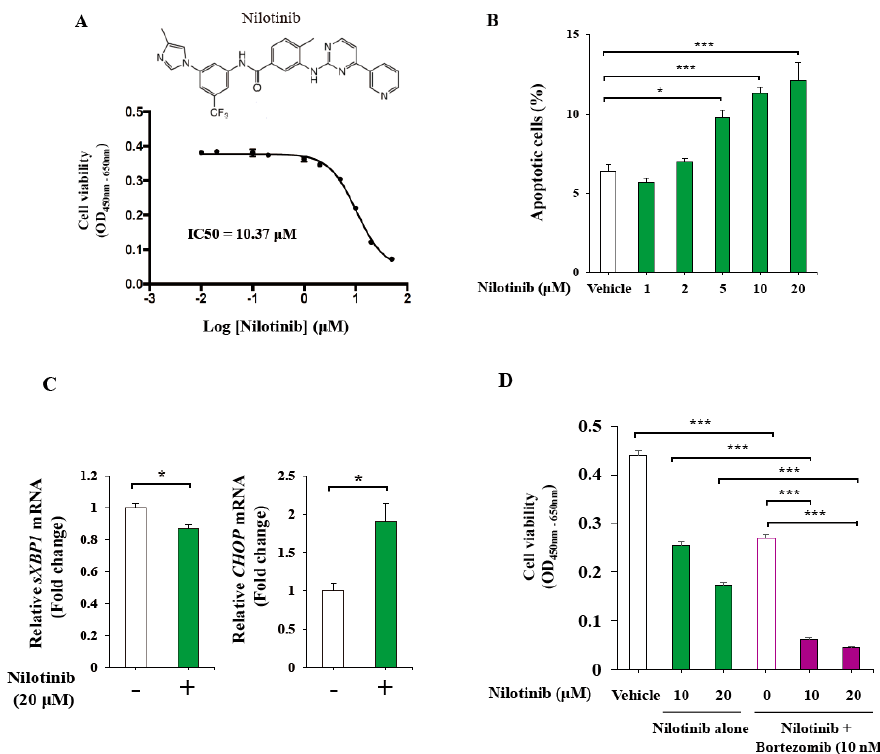
Figure 4. Anti-myeloma effects of nilotinib in IM-9 cells. ( A ) The structure of nilotinib and the cell viability assessed by the CCK-8 assay in IM-9 cells treated with the indicated concentrations of nilotinib for 24 h ( n = 4). ( B ) The % apoptotic cells in IM-9 cells treated with vehicle (DMSO) or the indicated concentrations of nilotinib for 24 h ( n = 3). ( C ) Quantitative RT-PCR of the relative sXBP1 and CHOP mRNA levels from IM-9 cells treated with vehicle (DMSO) or 20 μ M of nilotinib for 24 h ( n = 3). ( D ) The cell viability assessed by the CCK-8 assay in IM-9 cells treated with vehicle (DMSO) or the indicated concentrations of nilotinib and bortezomib for 24 h ( n = 4). The data shown are as the mean ± SEM. *, p < 0.05; **, p < 0.01; ***, p < 0.001.